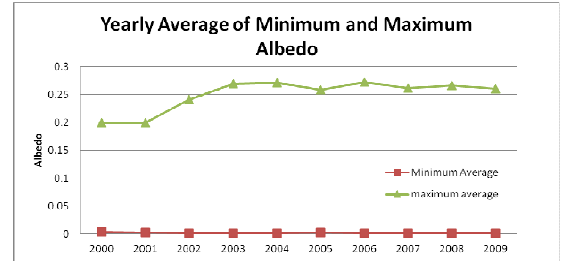
Figure 5. Yearly Minimum and Maximum Average Albedo